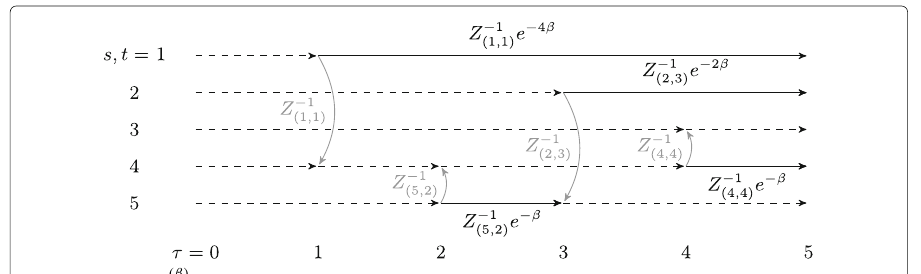
Fig. 2 Entries of P (β) ( C not in { 0,1 } for C : = { ( 1,4,1 ) , ( 5,4,2 ) , ( 2,5,3 ) , ( 4,3,4 ) } and a (cid:13) = { 0,5 } are indicated , a (cid:13) ,1 ) along with solid arcs (gray for spatial arcs; black for temporal arcs); unit entries correspond to dashed